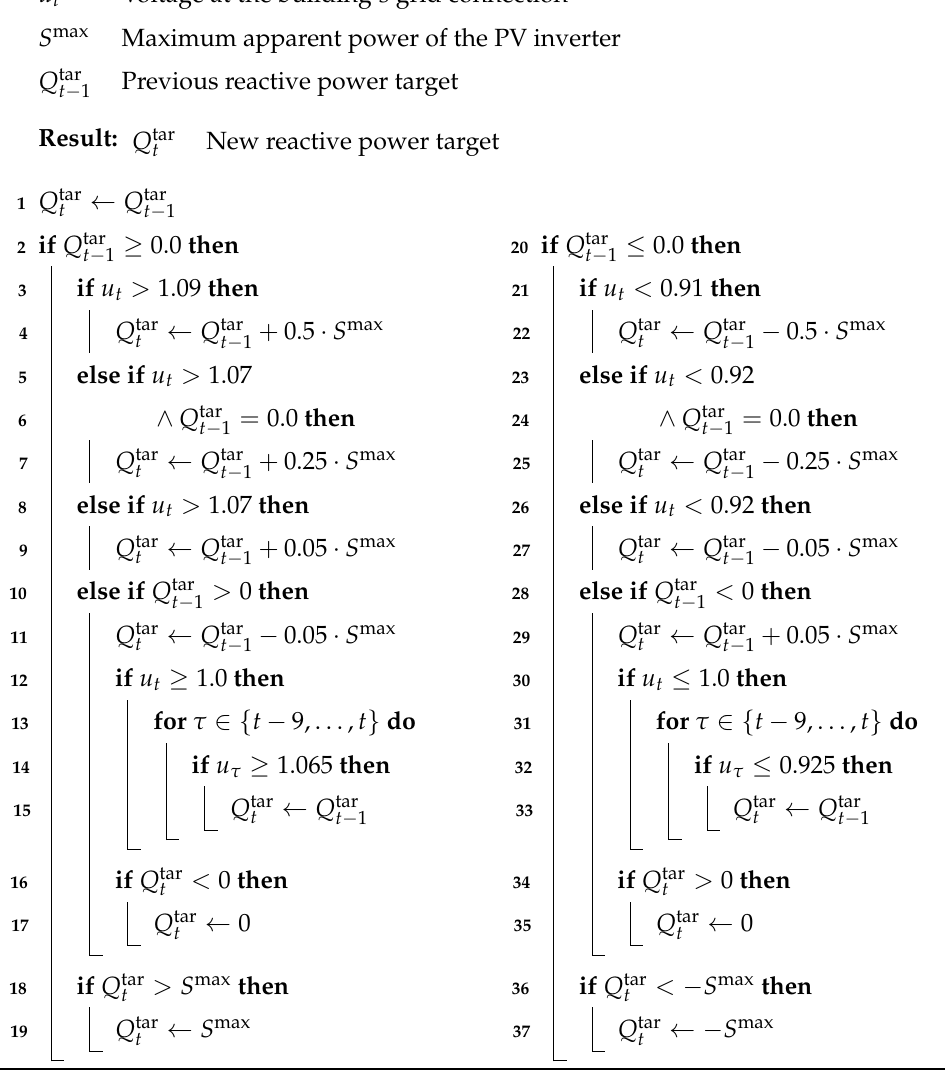
Algorithm 2: The determination of reactive power targets by a building. In the decentralized grid control strategy, eachs building performs this algorithm